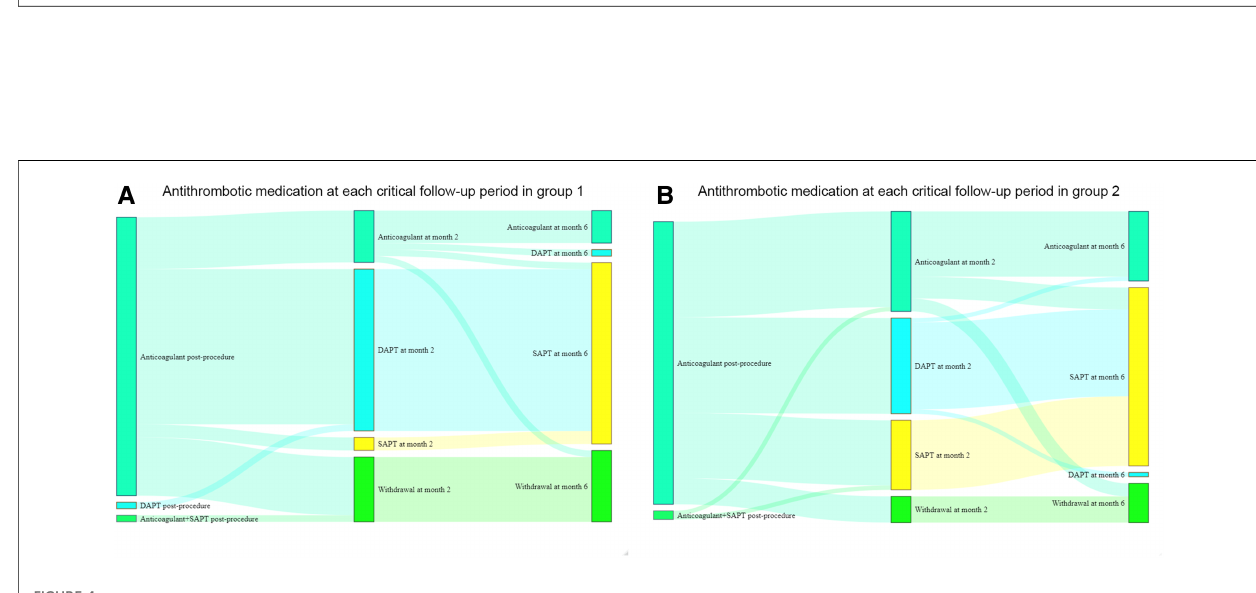
FIGURE 3 Subgroup analysis. BMI, body mass index; CBA, cryoballoon ablation; LAAO, left atrial appendage occlusion; RFA, radiofrequency ablation.